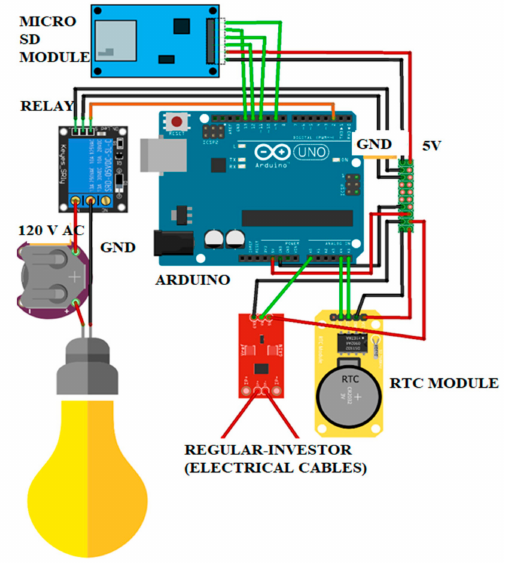
Figure 4. Control circuit